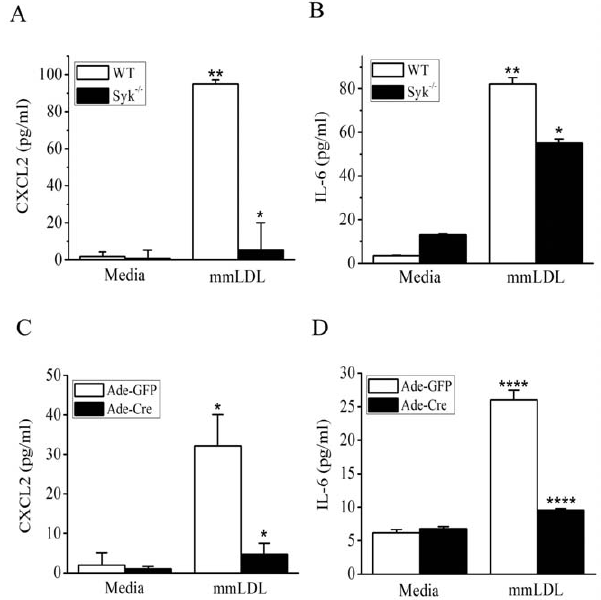
Figure 6. Secretion of CXCL2 (MIP-2) and IL-6 by WT and Syk 2 / 2 macrophages stimulated with mmLDL. BMDM from WT or Syk 2 / 2 mice ( A and B ) and resident peritoneal macrophages from Syk flox/flox mice infected with adenovirus expressing GFP or Cre (for 48 hours at 500 MOI) ( C and D ) were incubated for 6 hours with media or 50 m g/ml mmLDL. Cell culture media were collected and CXCL2 and IL-6 protein levels were measured by ELISA. Mean 6 SEM (n=3). *, p , 0.05; ****, p , 0.00005 WT vs. Syk 2 / 2 .